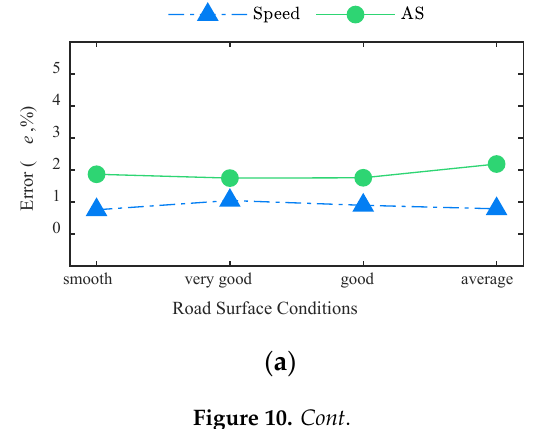
( a ) Figure 10. Cont